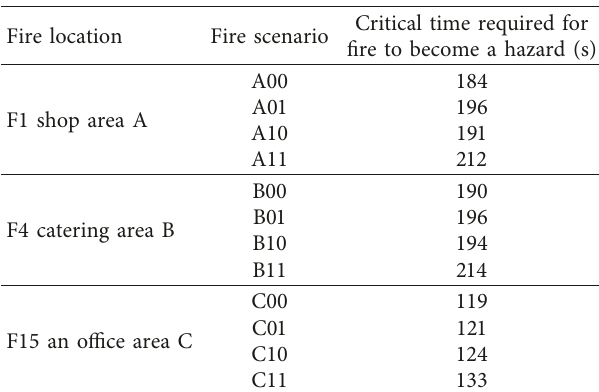
Table 6: Critical time required for fire to become a hazard for the three functional